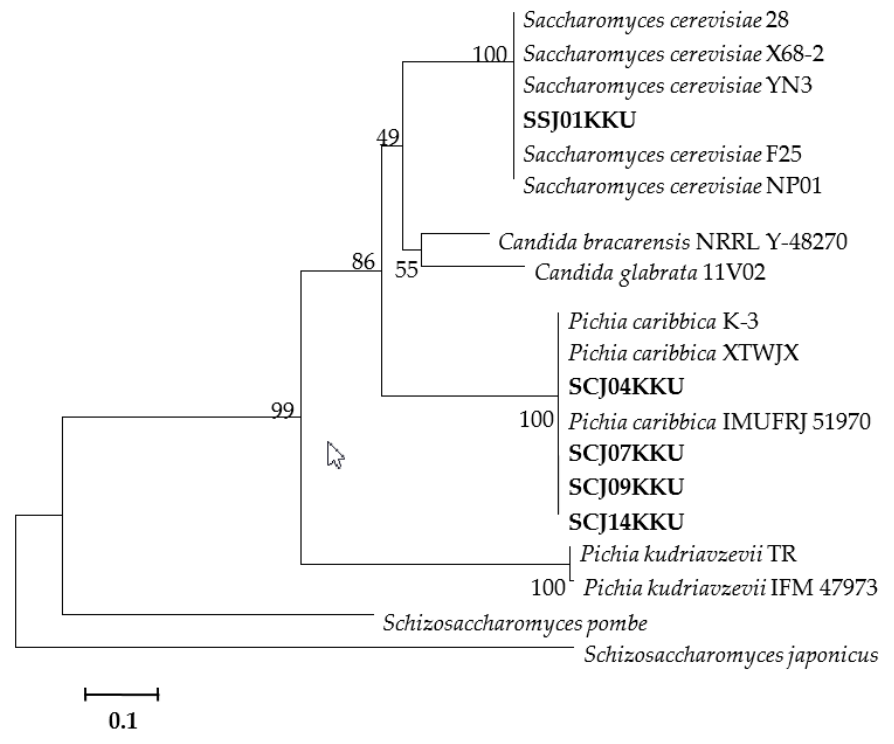
Figure 5. Phylogenetic relationship of SCJ04KKU, SCJ07KKU, SCJ09KKU, SCJ14KKU and SSJ01KKU based on a combined sequence analysis of the ITS1 and ITS2 regions. Clustering was performed using the neighbor-joining method, MEGA (Molecular Evolutionary Genetics Analysis) Version 5. The percentages at the nodes indicate the levels of bootstrap support for the branch point based on 1000 bootstrap replicates. The scale bar represents 0.1 nucleotide substitution per sequence position.